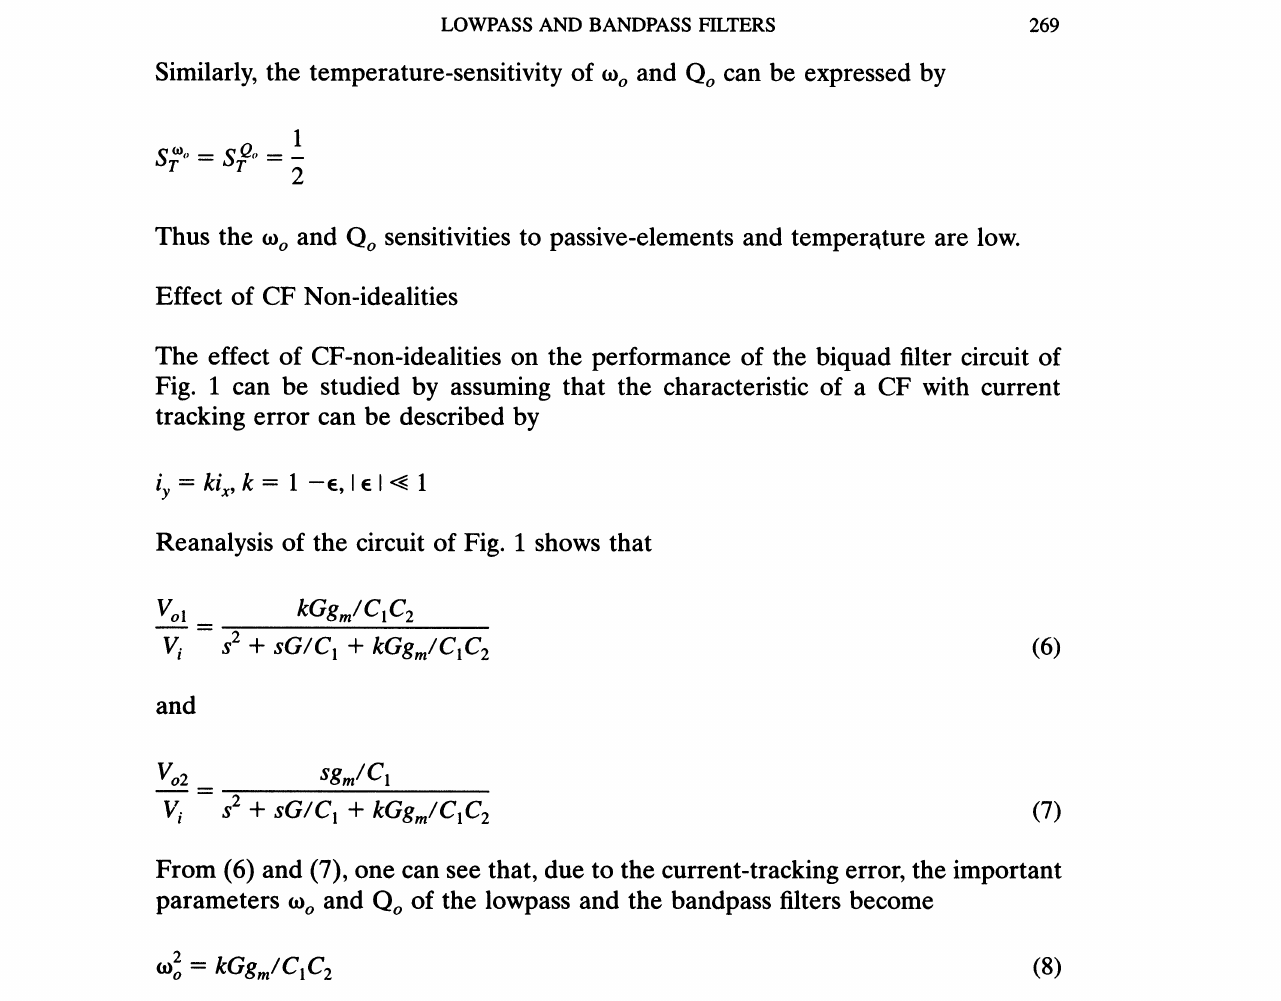
FIGURE 1 Proposed lowpass and bandpass biquad